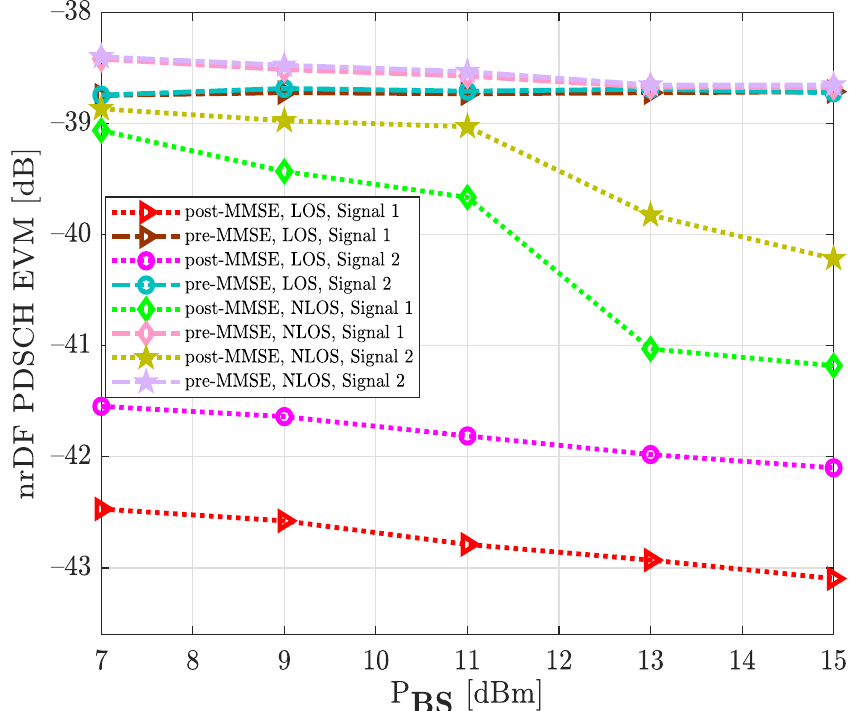
Figure 14. Median EVM at physical downlink shared channel for two modulation schemes, LOS and NLOS environment, and equalization step under real